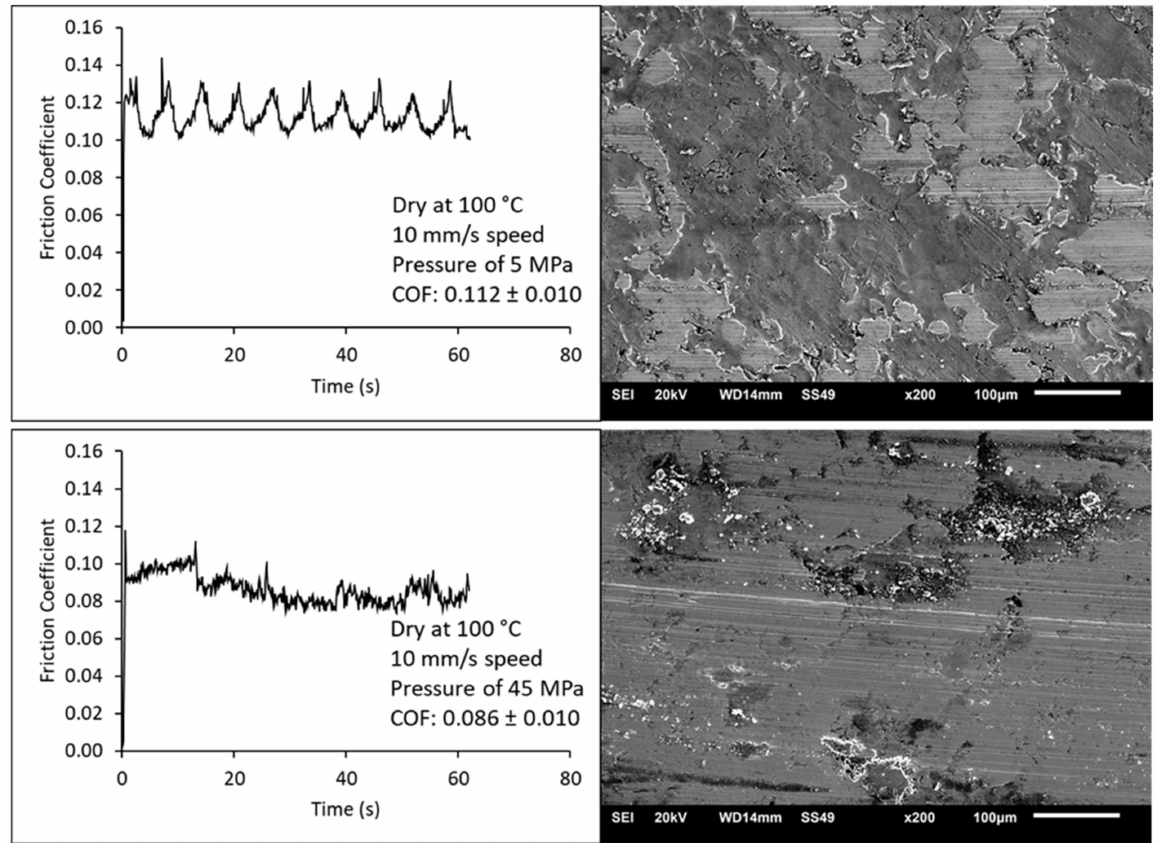
Figure 12. Measurement of coefficient of friction (COF) together with SEM analysis, for tests without lubricant, at 100 ◦